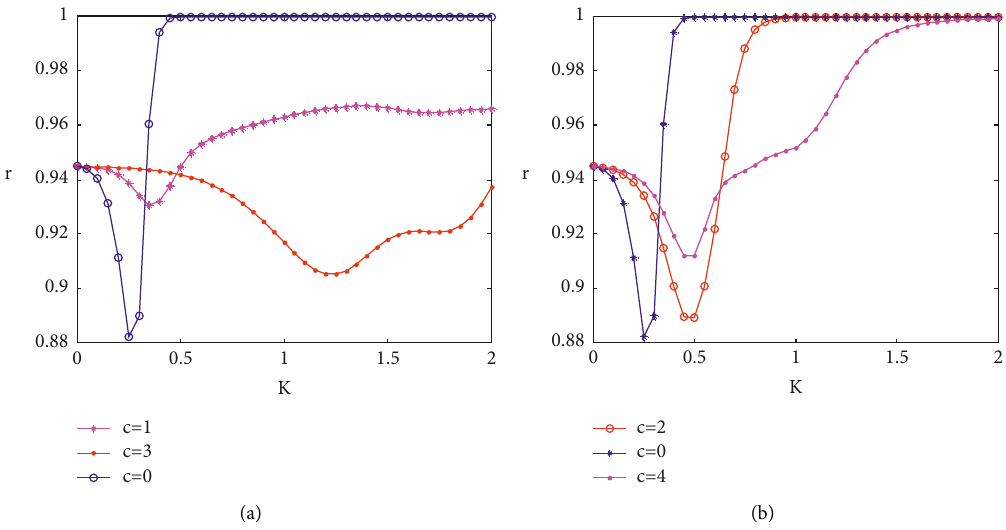
Figure 5: The evolutions of order parameters for a ring network with different weight